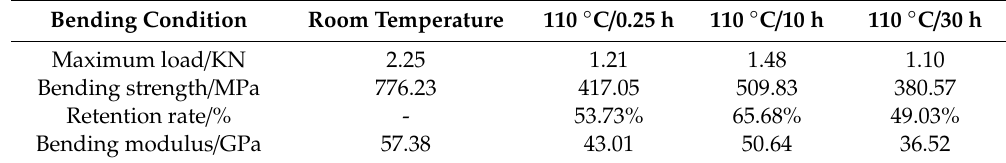
Table 3. Bending stress of braided structure specimens at room temperature and 110 ◦ C.